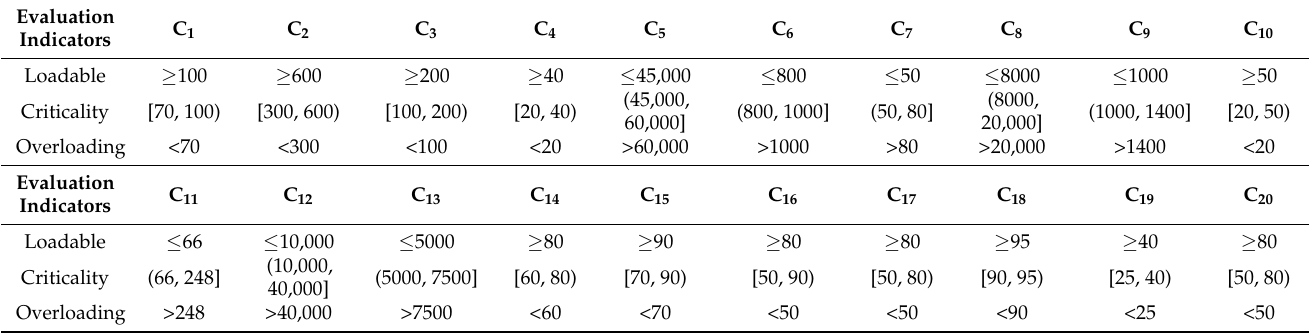
Figure 1. Index system for Harbin water environmental carrying capacity. Table 1. Evaluation index grading standards.